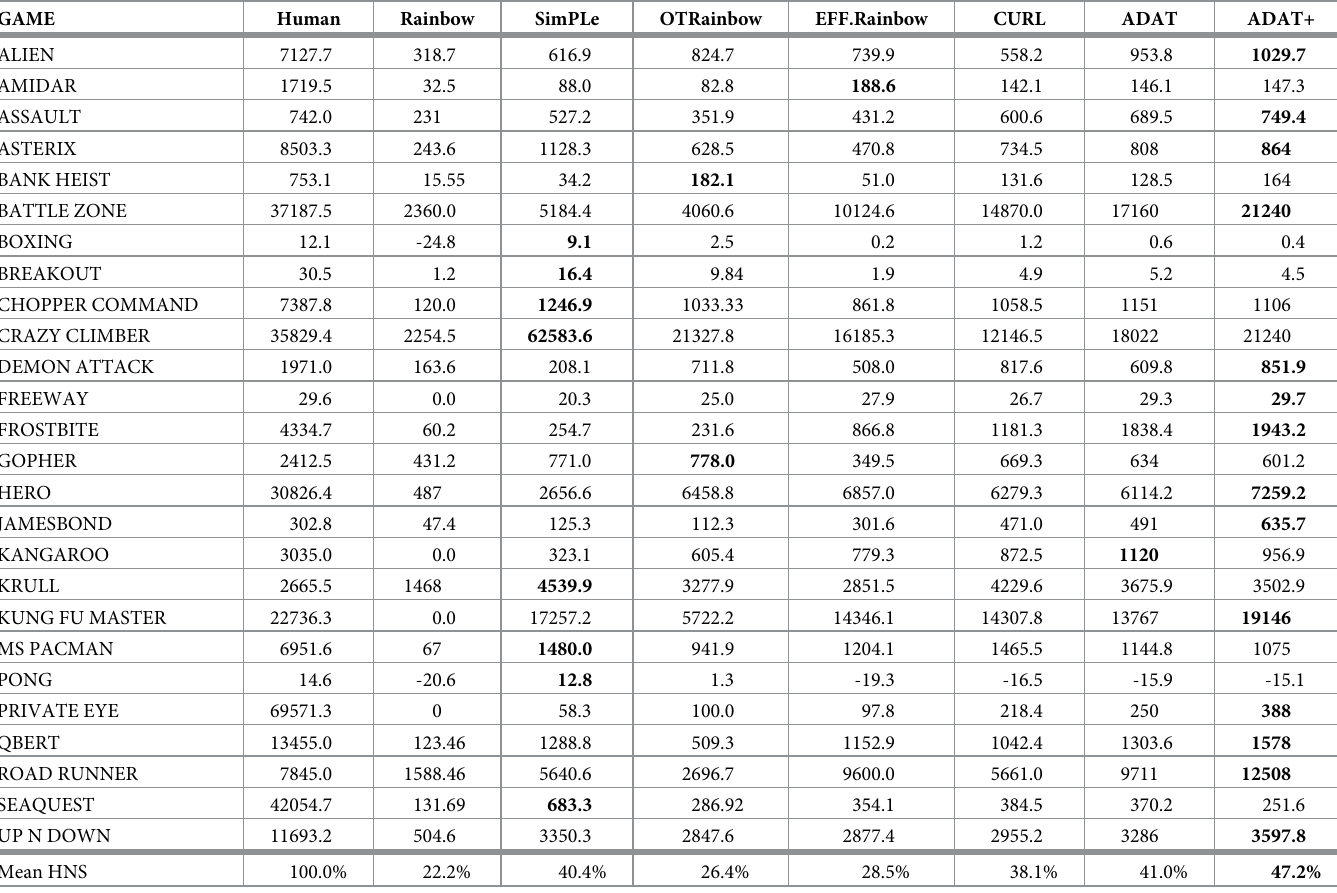
Table 3. Comparison of sample